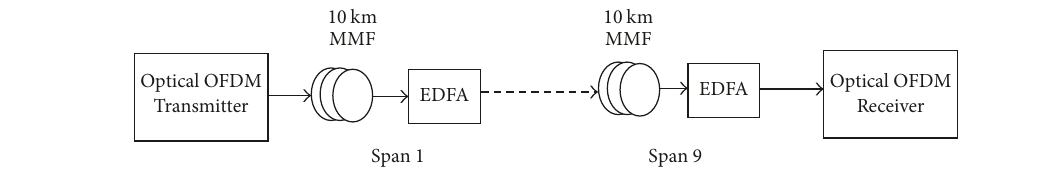
Figure 5: DDO-OFDM system in multispan configuration.